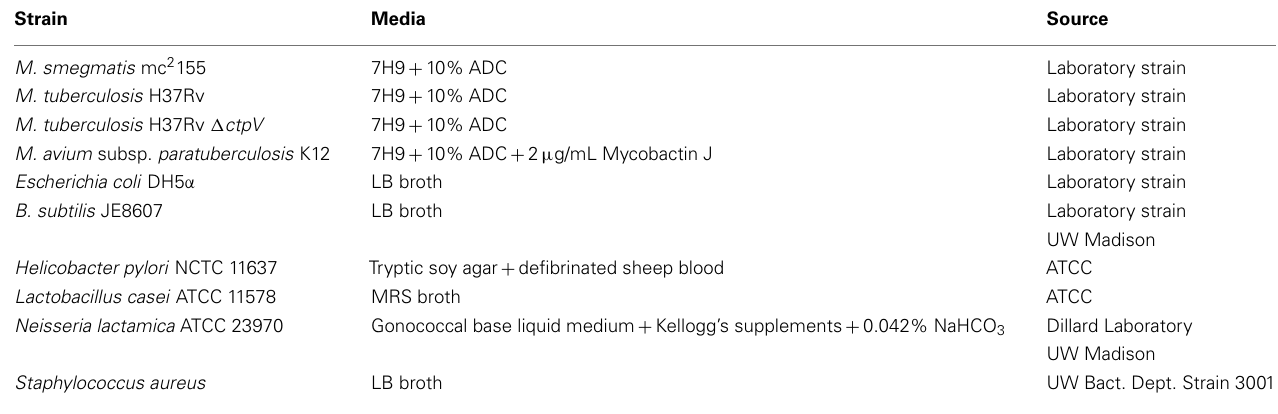
Table 1 | Bacterial strains used in this